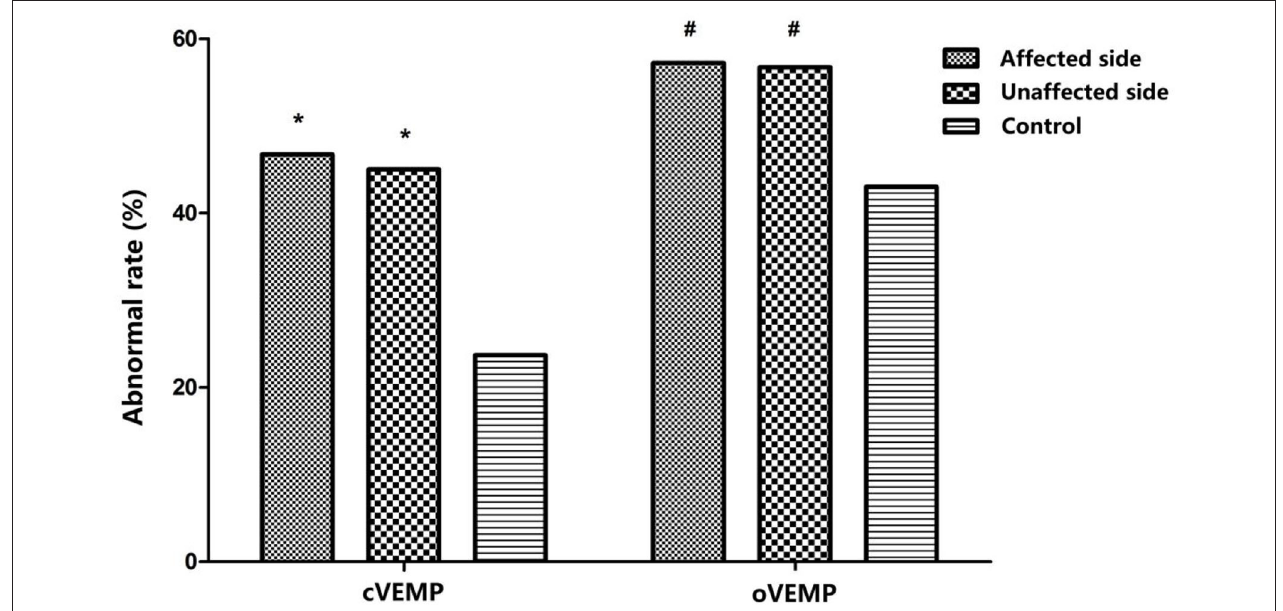
FIGURE 1 | Comparison of abnormal rates of cervical vestibular-evoked myogenic potential (cVEMP) and ocular vestibular-evoked myogenic potential (oVEMP) among affected ears and unaffected ears in the benign paroxysmal positional vertigo (BPPV) group and normal control ears; * p < 0.01, # p < 0.05, compared with